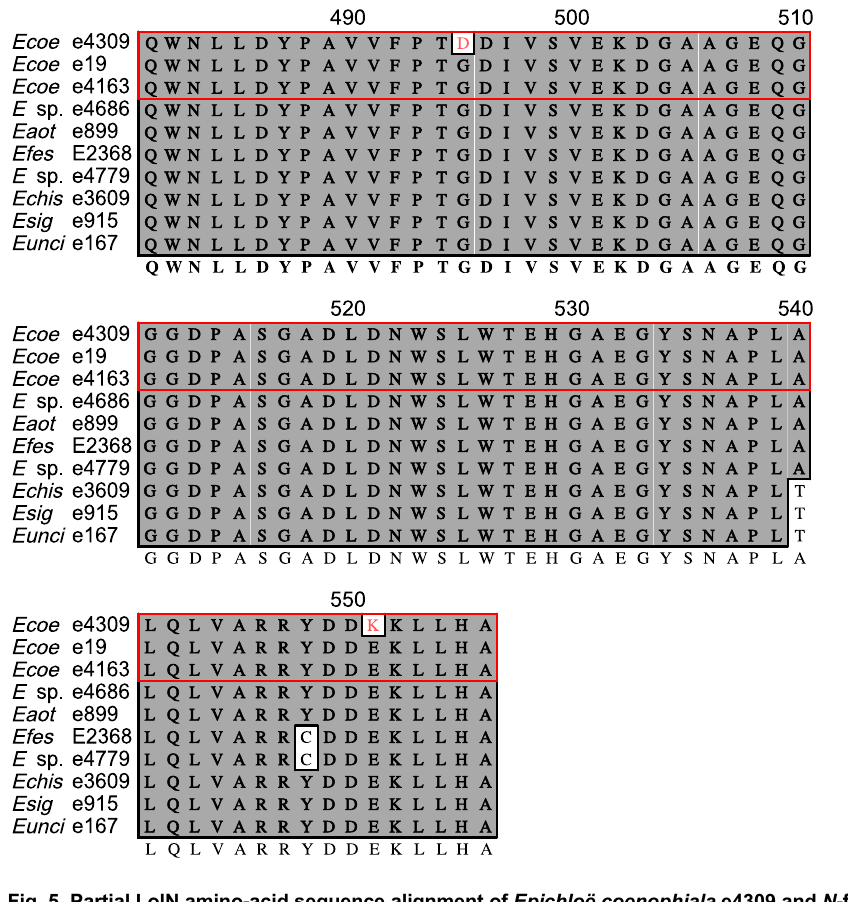
Fig. 5. Partial LolN amino-acid sequence alignment of Epichloe¨ coenophiala e4309 and N -formylloline (NFL) producers. Red-framed sequences are three different E. coenophiala isolates. Ecoe 5 Epichloe¨ coenophiala , Eaot 5 Epichloe¨ aotearoae , Efes 5 Epichloe¨ festucae , Echis 5 Epichloe¨ chisosa , Esig 5 Epichloe¨ siegelii , Eunci 5 Epichloe¨ uncinata .